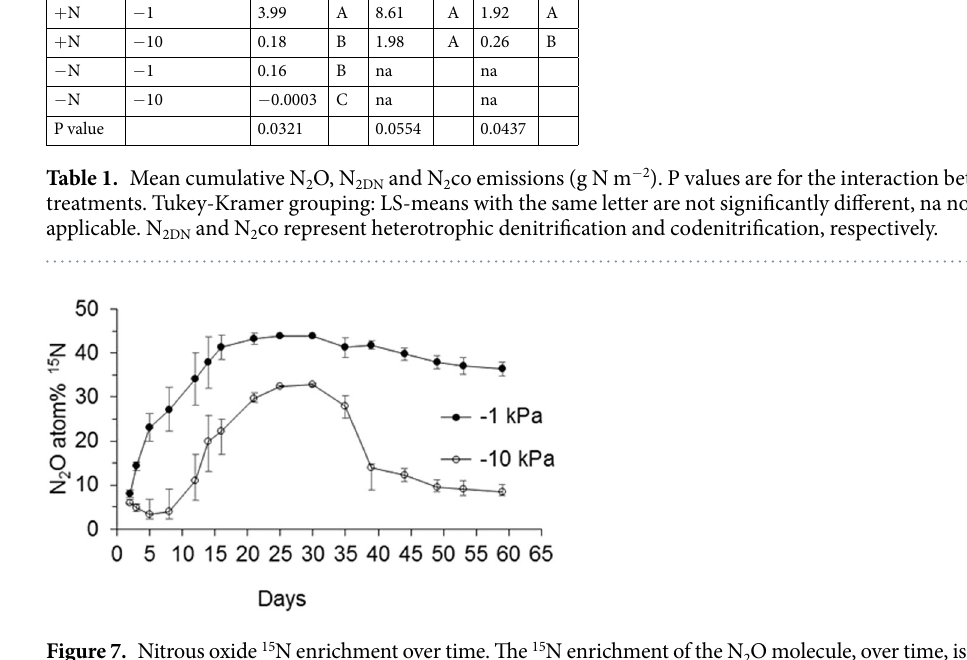
Figure 7. Nitrous oxide 15 N enrichment over time. The 15 N enrichment of the N 2 O molecule, over time, is shown for N 2 O evolved from soil under near saturated ( − 1 kPa) or field capacity ( − 10 kPa) conditions, following 15 N urea application. Symbols are means (n = 4) with vertical error bars the standard error of the